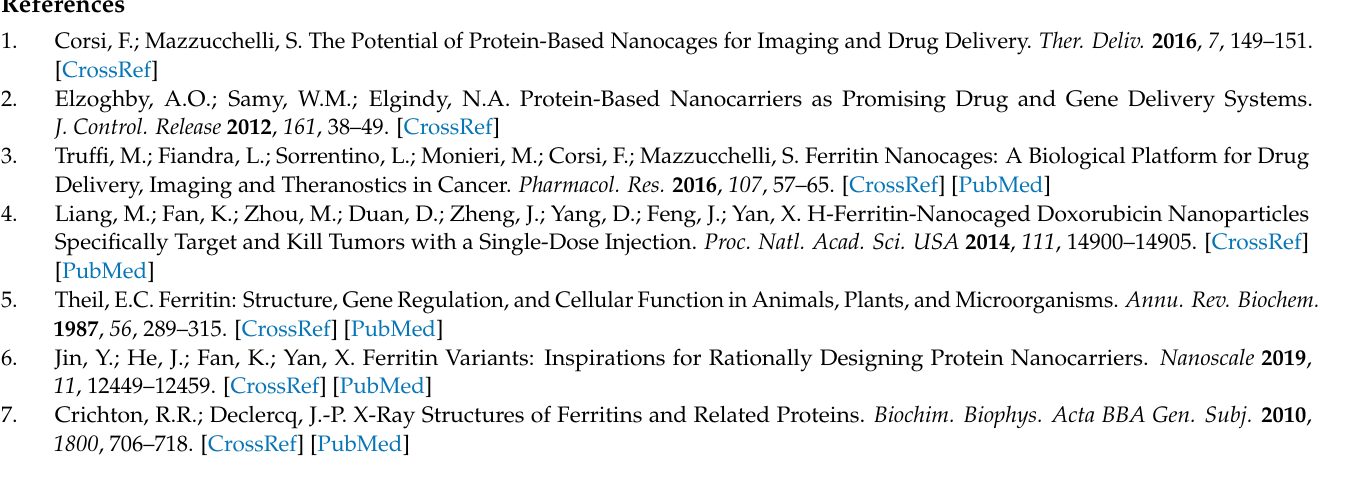
mL columns and then centrifuged (3000 × g , 2’) to force the flow of the protein through the column. Protein recovery has been measured by absorbance reading (A280 nm) (a); ETX concentration of the protein before the incubation and after the centrifugation have been measured by LAL test (b).; Figure S2. TEM representative images of native HFn (a), and after purification with Endotrap HD resins (b), Triton X-114 (c) and the combined method of the two (d). Scale bar = 50 nm.; Figure S3. LAL reaction curves and Triton X-114 interference. Representative reaction plots of the standards at different ETX content (50, 5, 0.5, 0.05 and 0.005 EU/mL respectively) used in the LAL kinetic turbidimetric test to prepare the standard curve (a). The standard curve (b) is made by plotting on the x axis the time (minutes) when the turbidity of each one of the standards reaches an absorbance of 0.1 (dashed line of panel a), and on the y axis the relative ETX concentration. Interference of high concentrations of Triton X-114 (1%) in LAL test turbidimetric readings, as shown in a sample of HFn purified with 6 cycles of Triton X-114 before G25 detergent removal (empty squares); Triton X-114 interference can be observed also at low concentrations (0.1%), where it inhibits the reaction of the spike 5 EU/mL (red empty triangles) as compared with the spike in PBS alone (green empty circles) (c). Representative turbidimetric plots of HFn purified with 6 cycles of Triton X-114 where the detergent has been removed by G25 columns (empty triangles). The plot of the spike (empty rotated squares) overlaying the 5 EU/mL standard in PBS, confirms the successful removal of the detergent (d).; Table S1. HFn FITC